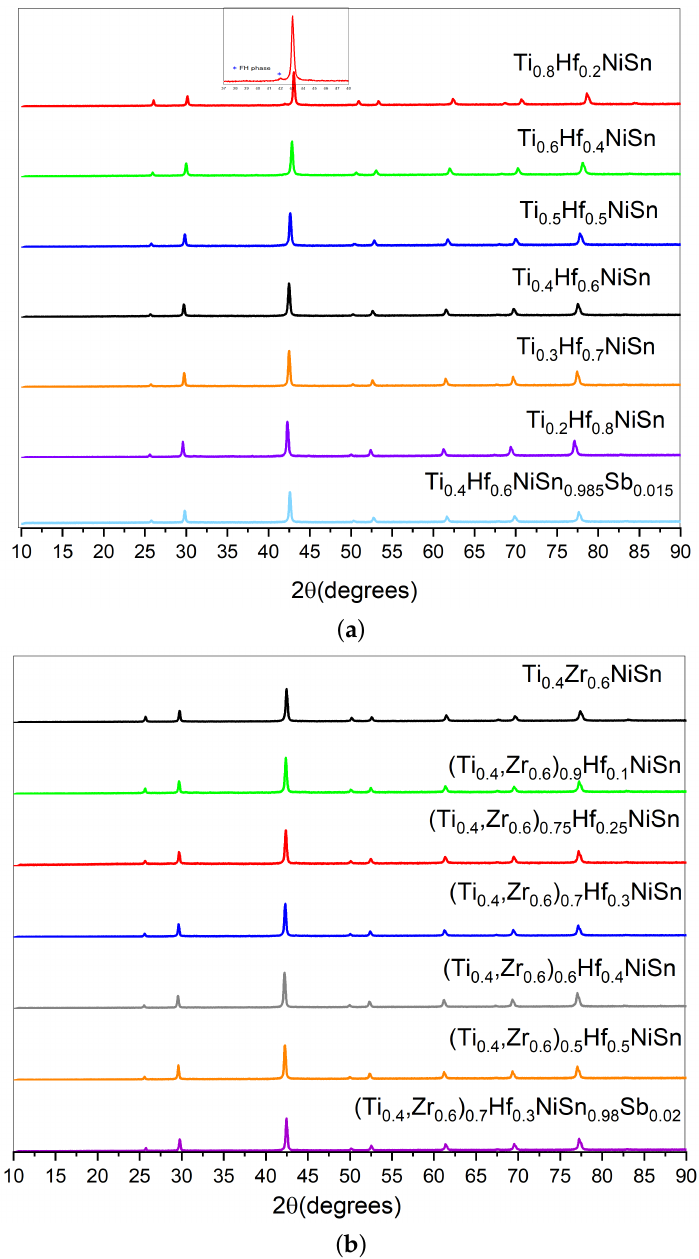
Figure 3. ( a ) PXRD patterns for the sintered pellets Ti 1 − x Hf x NiSn. ( b ) PXRD patterns for the sintered pellets of (Ti 0.4 Zr 0.6 ) 1 − y Hf y